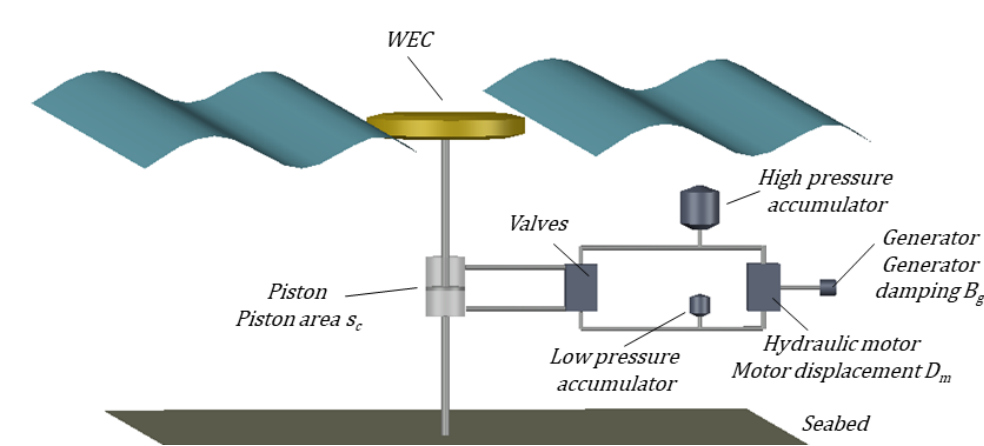
Figure 1. Schematic representation hydraulic PTO for heaving cylindrical